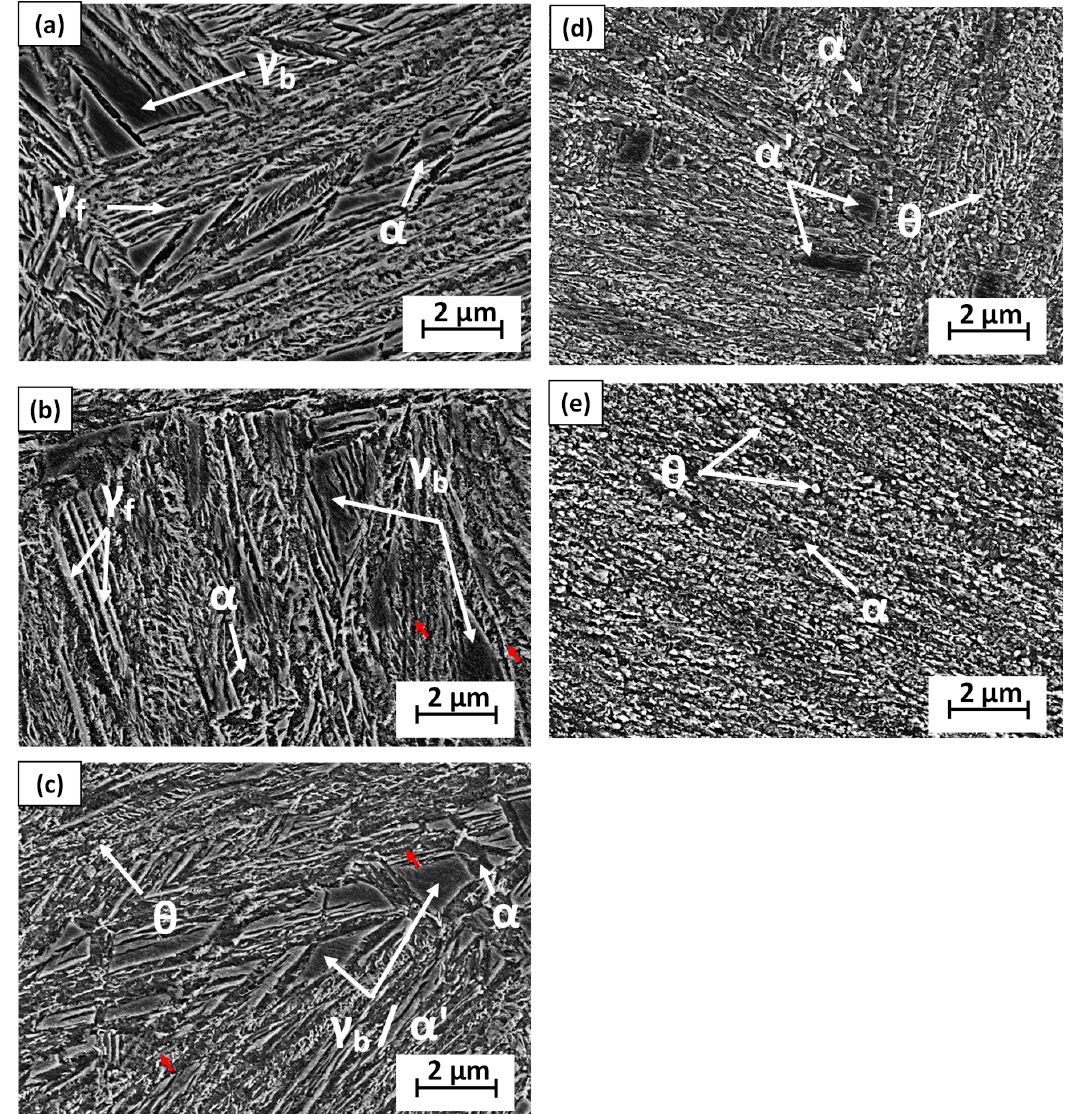
Figure 10. SEM micrographs after tempering for 1 h at ( a ) 450 °C, ( b ) 500 °C, ( c ) 550 °C, ( d ) 600 °C, and ( e ) 650 °C in the case of 06CV steel.